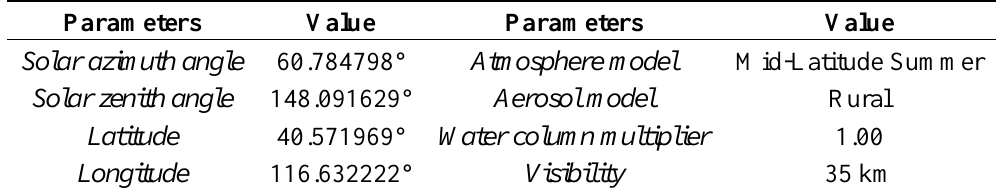
Table 1. The parameters used for the atmospheric correction in this